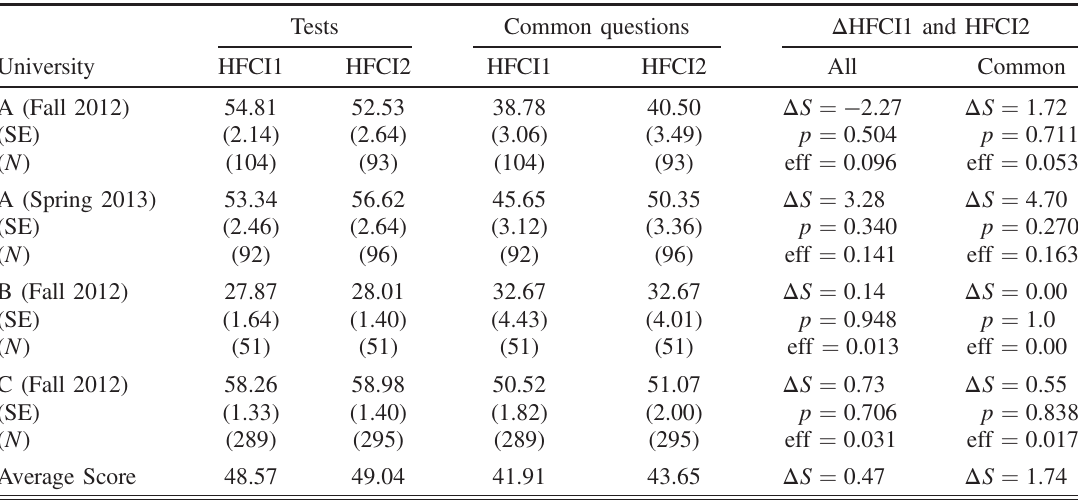
TABLE III. Mean HFCI scores at universities A and B. HFCI scores at universities A and B are given as well as scores on the three questions that the HFCI versions had in common. Score differences ( Δ S ¼ HFCI 2 − HFCI 1 ) and their p values and effect sizes are given to the right. The average score is a nonweighted average of the sample means. Standard error (SE) and sample size ( N ) are listed for each